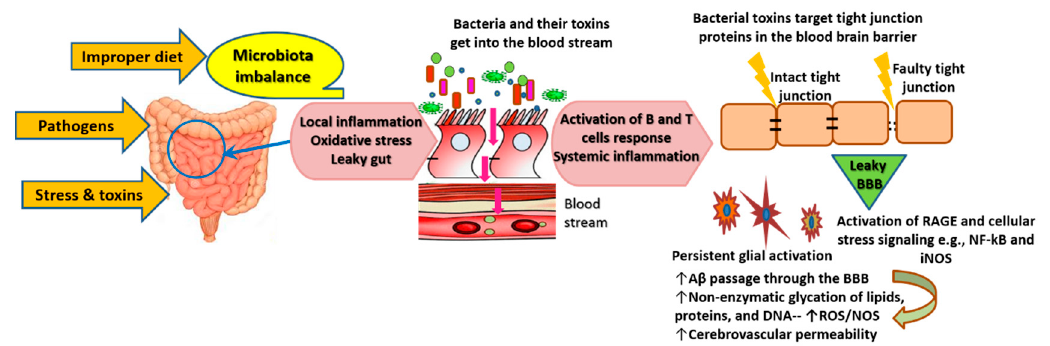
Figure 1. Contribution of disrupted microbiota to the permeability of the blood brain barrier and neuroinflammation in Alzheimer’s disease. Abbreviations: ↑ denotes increase, BBB: blood brain barrier, RAGE: receptor for advanced glycation end products, NF- κ B: nuclear factor-kappa B, iNOS: inducible nitric oxide synthase, A β : beta-amyloid protein fragments, ROS: reactive oxygen species, NOS: nitric oxide species.